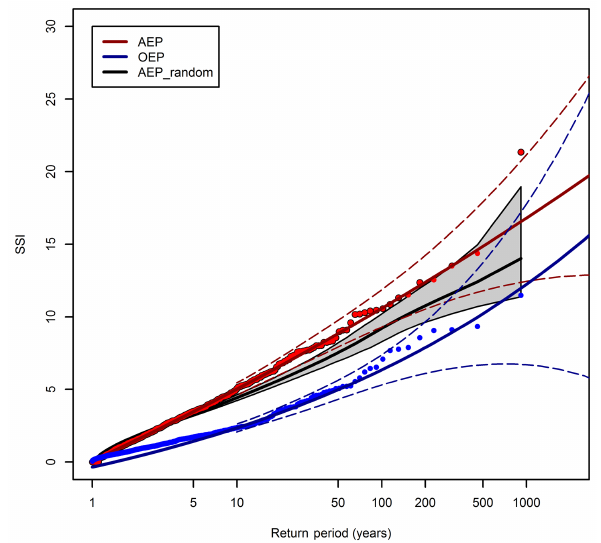
Figure A3. As Fig. 4, but only retaining the top three events of every